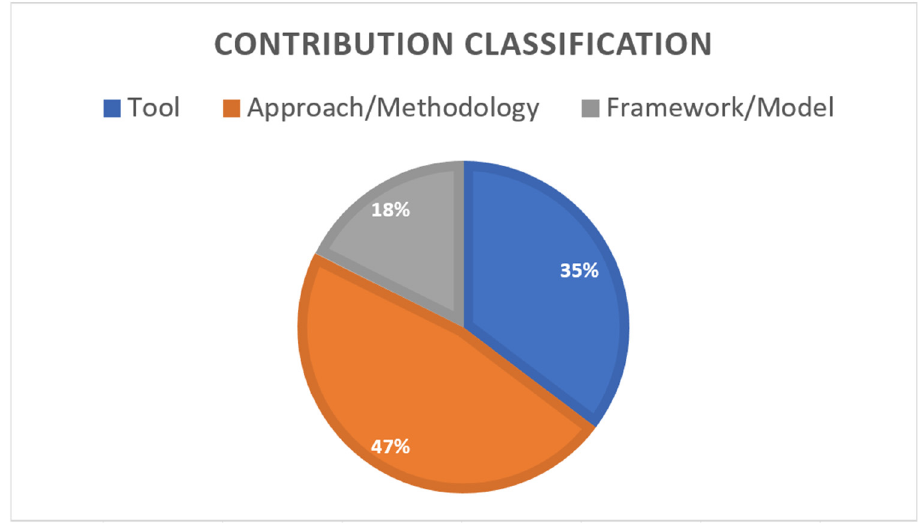
Figure 4. Contribution classification.